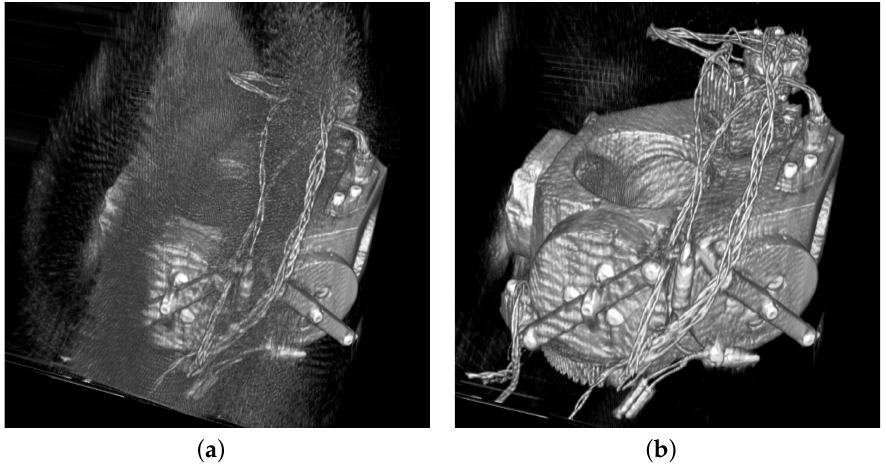
Figure 15. Three-dimensional reconstruction result: ( a ) 3D reconstruction before performing neural network correction; ( b ) 3D reconstruction after performing neural network